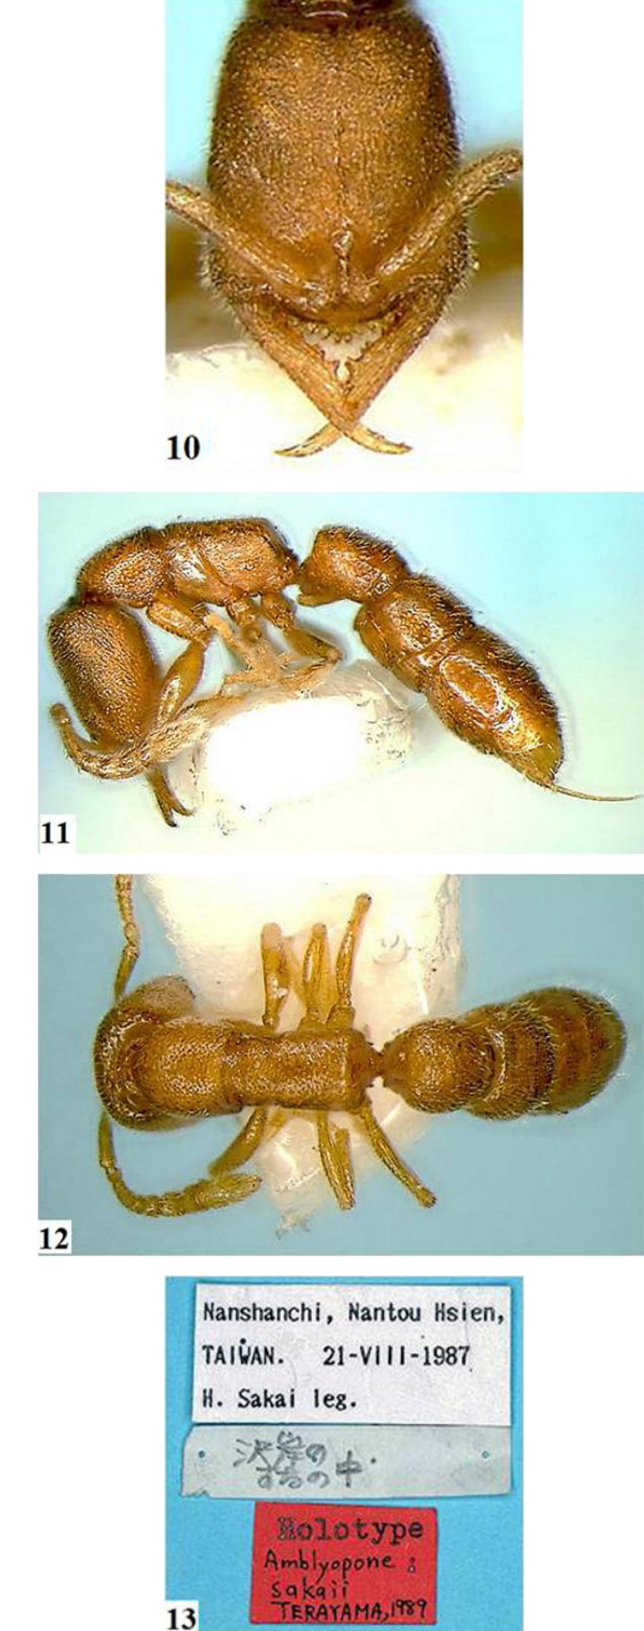
Fig 7-9. Images illustrating the measurements used. 7. head in full- face view with measuring lines for HL, HW, SL and ML. 8 . body in lateral view with measuring lines for WL, PH, PL and GL. 9 . body in dorsal view with measuring lines for PW and DPW.